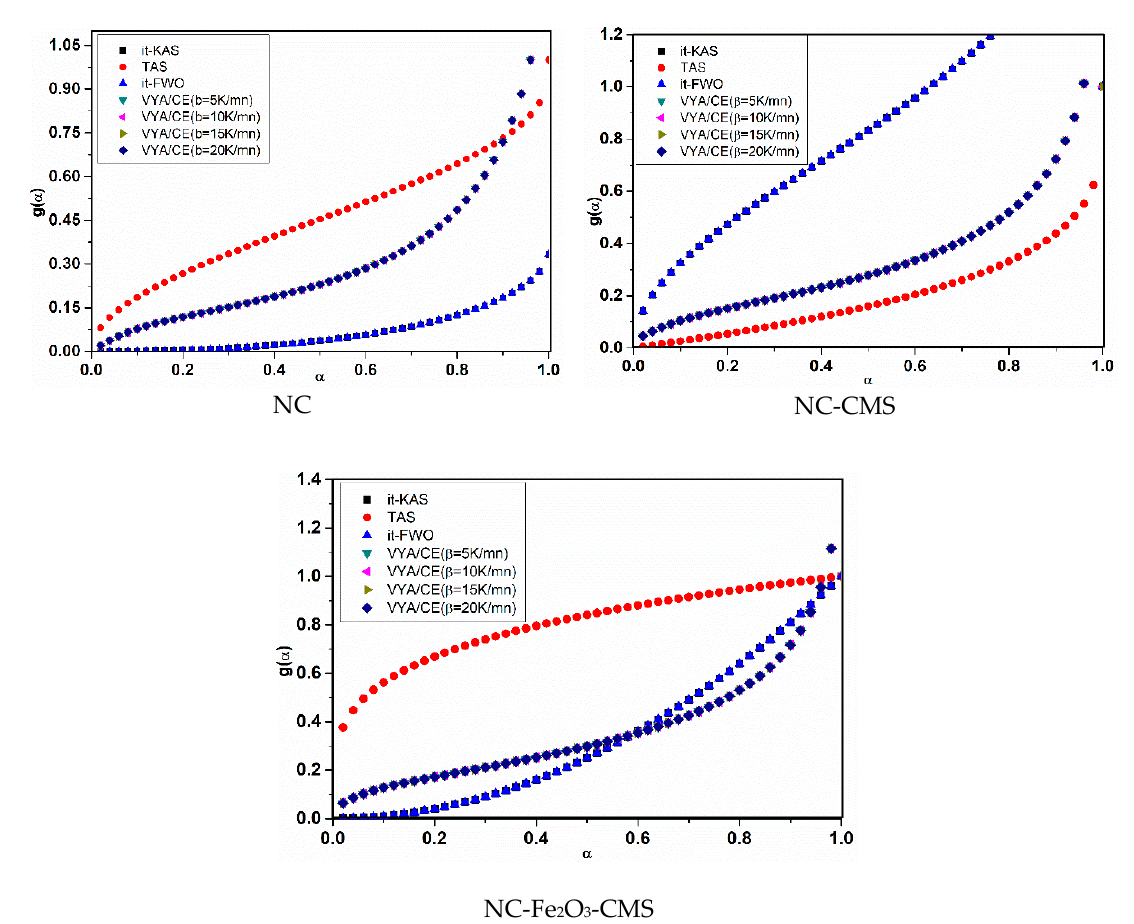
Figure 10. Integral reaction model evolution for the different systems studied.